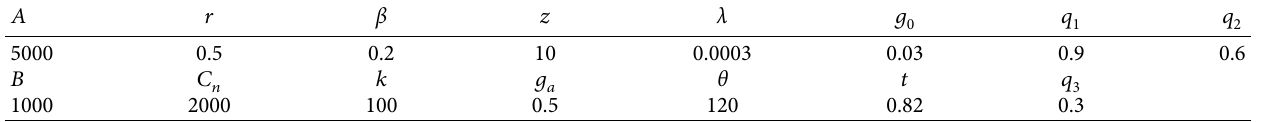
Table 4: The model